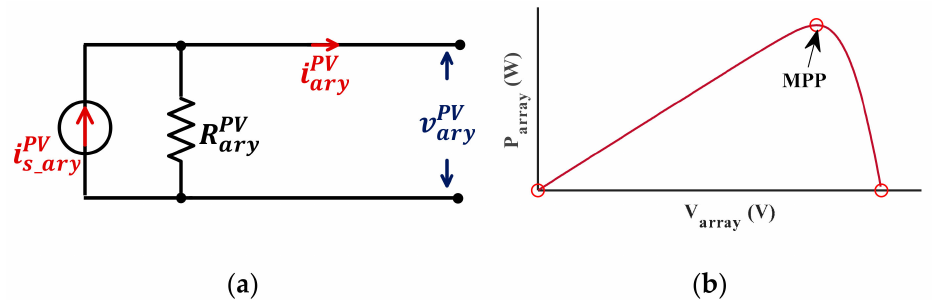
Figure 7. Solar PV array ( a ) Norton equivalent circuit; ( b ) P-V relationship